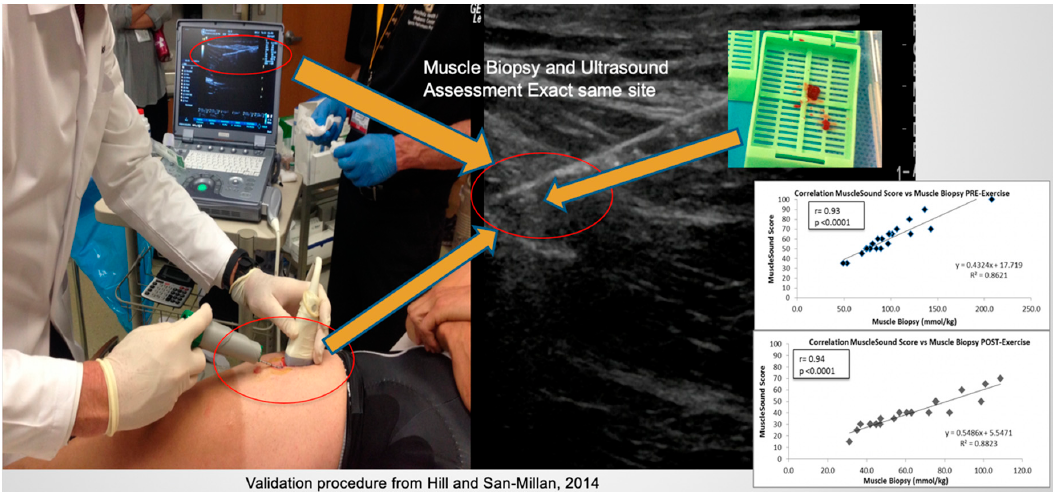
Figure 1. Validation procedure through ultrasound-guided muscle biopsy (Hill and San-Millan, 2014). The ultrasound-guided muscle biopsy allows to determine the exact site from where the muscle biopsy was obtained. Only through this procedure is possible to correlate the glycogen content from the muscle biopsy with the echogenicity of the image corresponding to the muscle biopsy site.